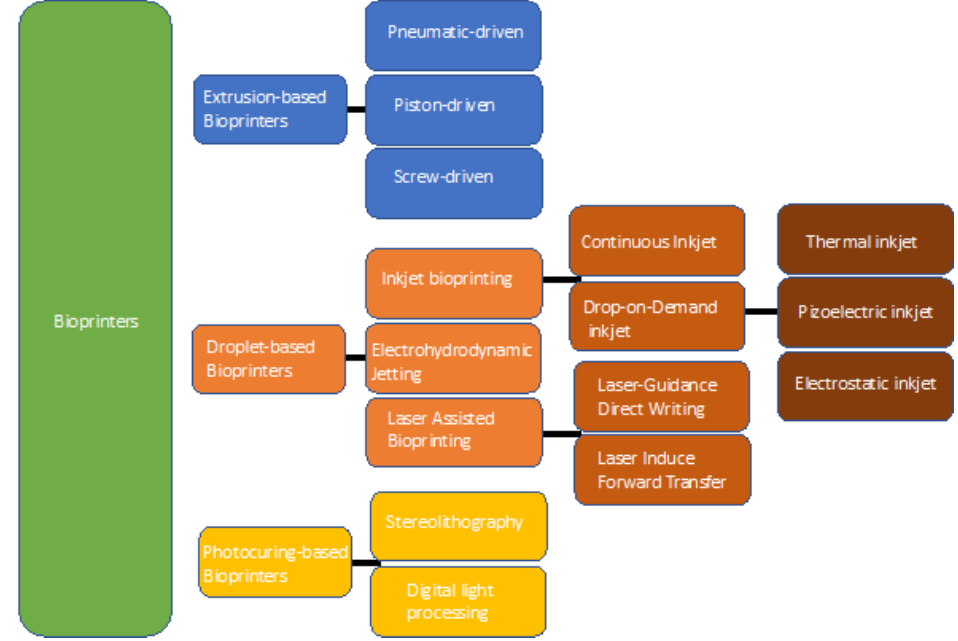
Figure 1. Overview of 3D bioprinting techniques.